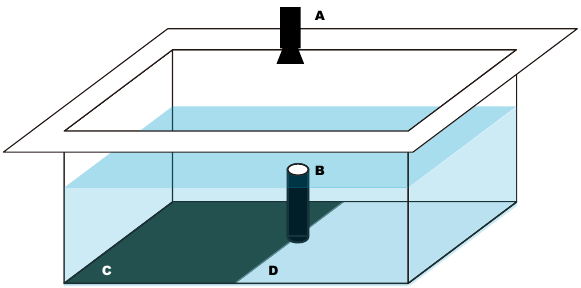
Figure 2. Diagram of the experimental arena. Video camera (A) is placed above the tank. Outflow tube (B) appears at the center of the tank. Algal cover creates the dark substrate in the tank (C) . The area where the bottom was cleaned, exposing the bright light blue color of the tank, which creates the light substrate (D)